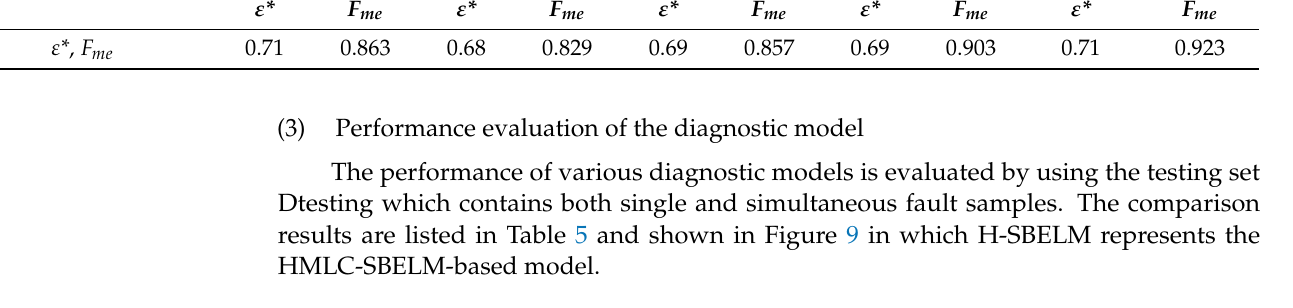
Table 5. The contrastive results of diagnostic models.